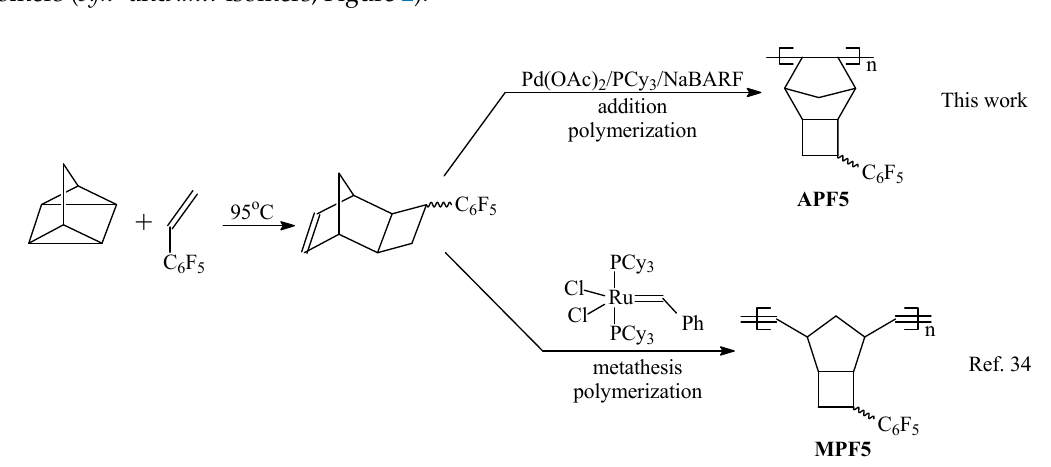
Figure 1. The synthesis of metathesis and addition polynorbornenes with C 6 F 5 side groups.